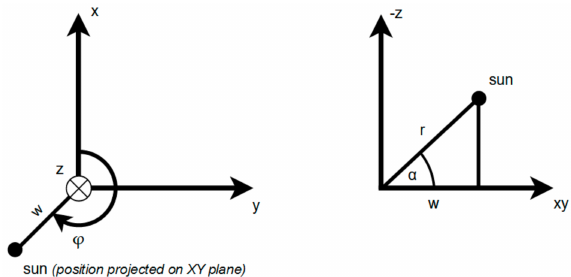
Figure 14. The transformation from the horizontal coordinate system to the three-dimensional Cartesian coordinate system. Here, ϕ represents the azimuth, α represents the elevation, r represents the distance from the coordinate system origin to the sun and w represents the distance from the coordinate system origin to the projection of the sun on the XY plane of the Cartesian coordinate